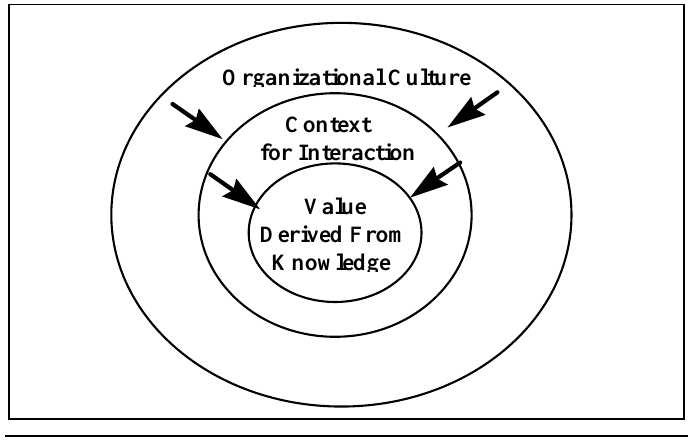
Organizational Culture Context for Interaction Value Derived From Knowledge